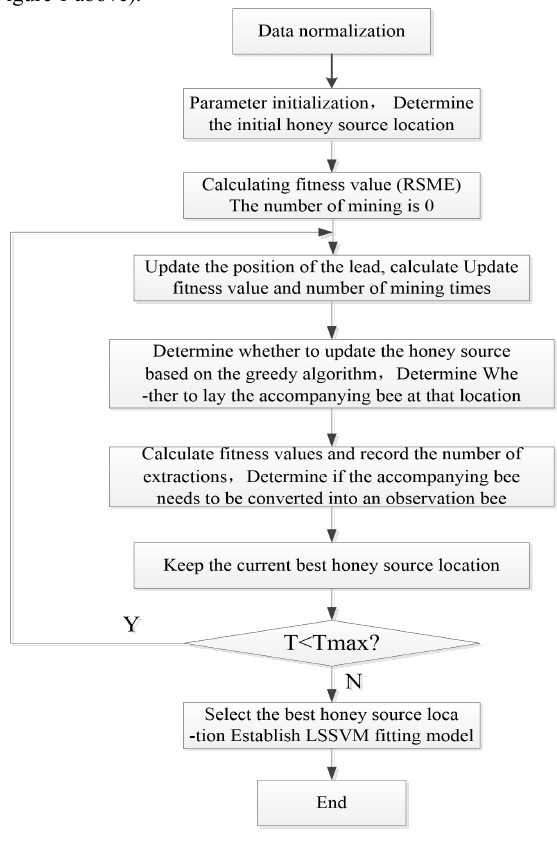
Figure 1. Process of ABC-LSSVM